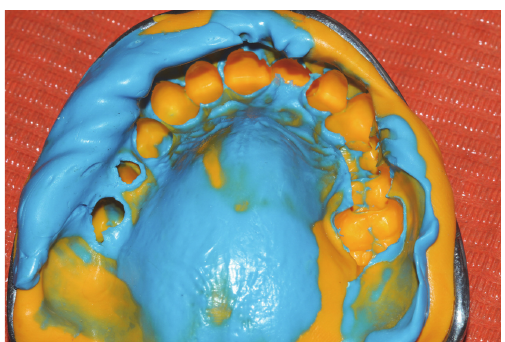
Figure 8: Crown cement and occlusal